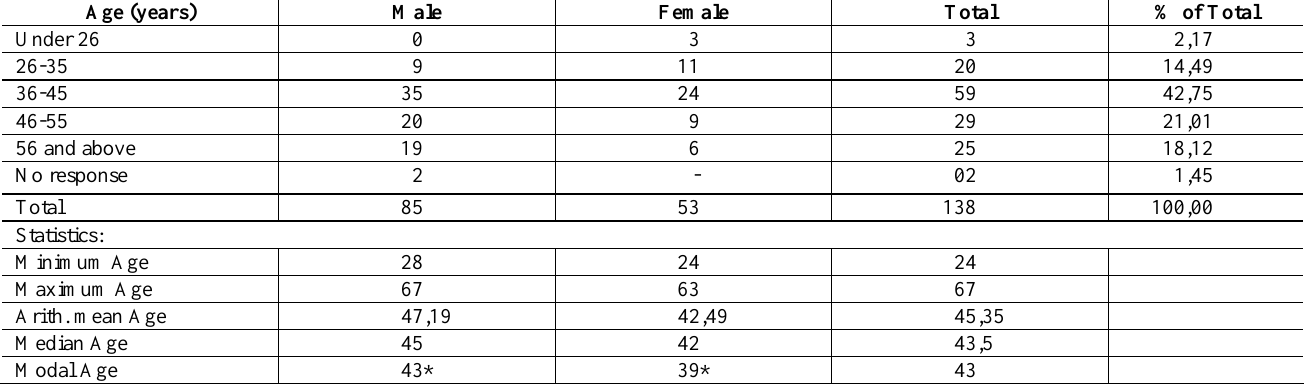
Table 1: Age distribution and statistics of cocoa marketers by gender, Idanre sample: Ondo State of Nigeria, 2000/2001